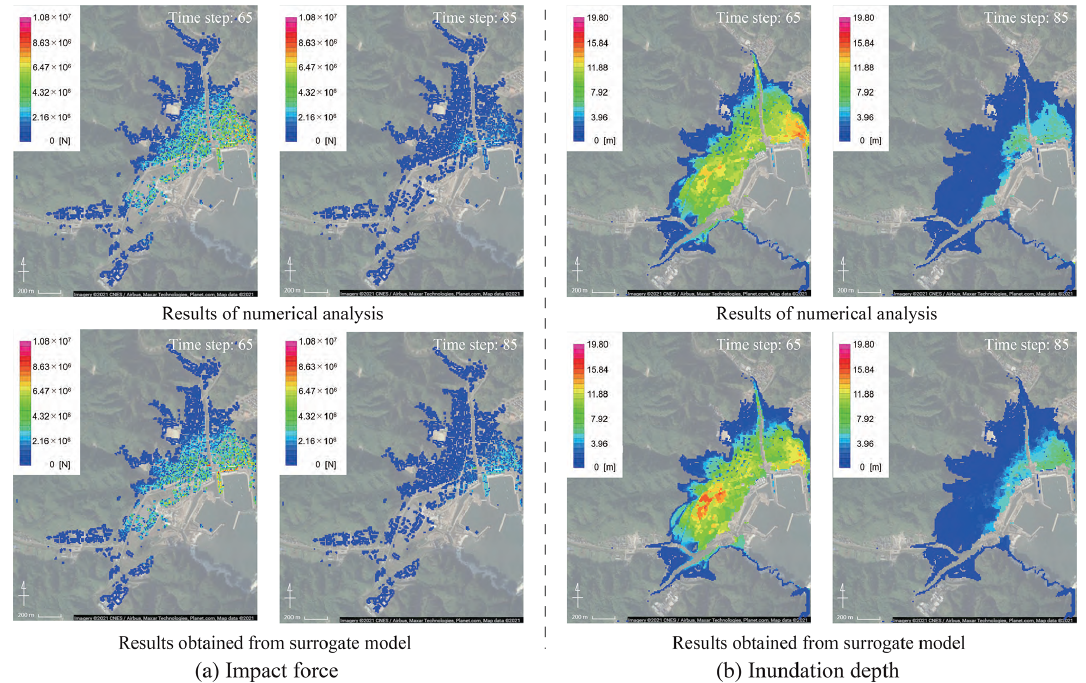
Figure 19. Snapshots of the results obtained from numerical analysis and those obtained from the surrogate models (S5R7) (© Google